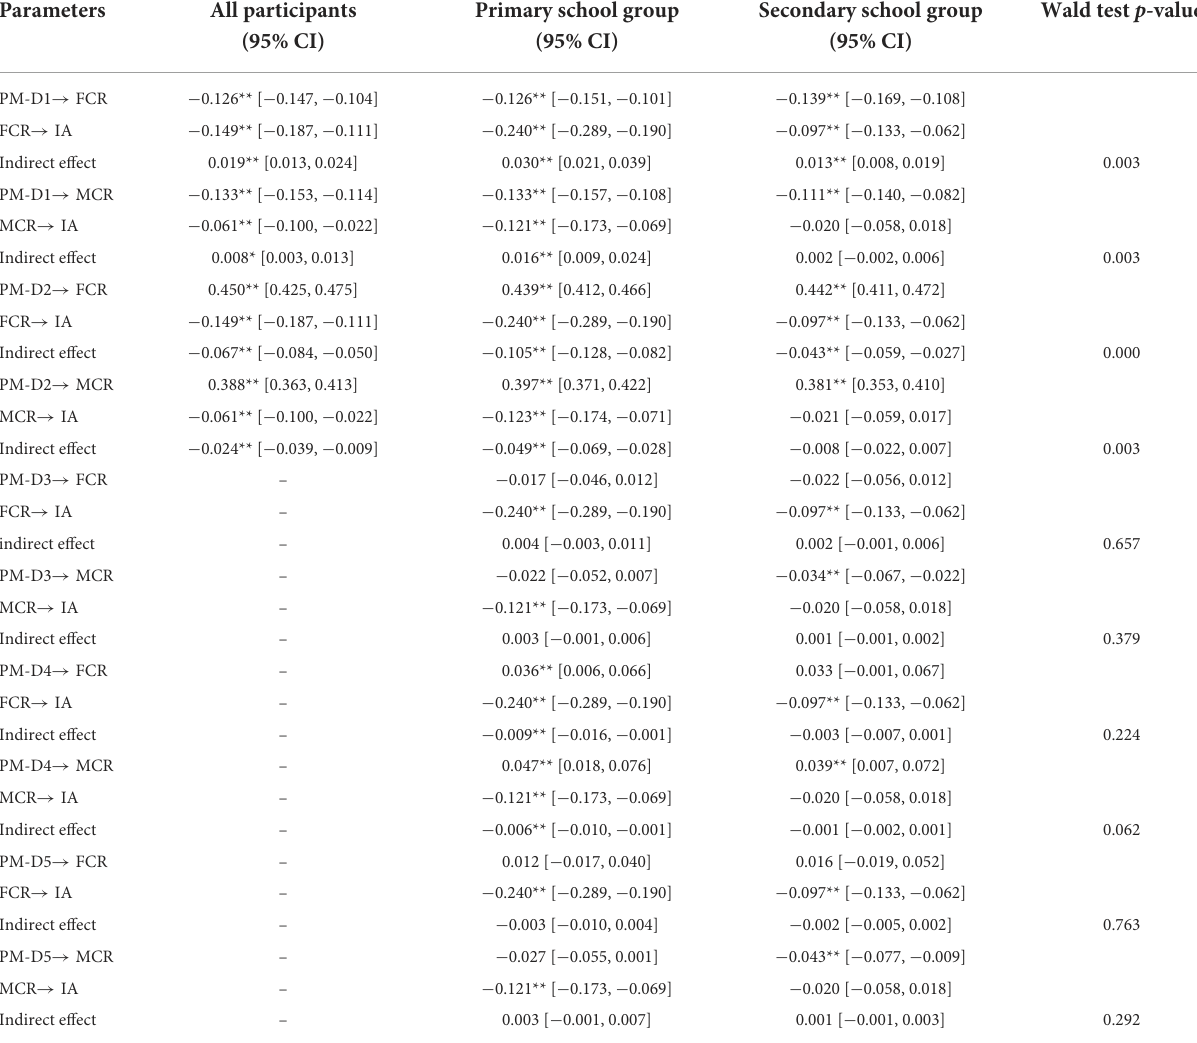
TABLE 3 Group differences in estimations of indirect effects from PM to IA.